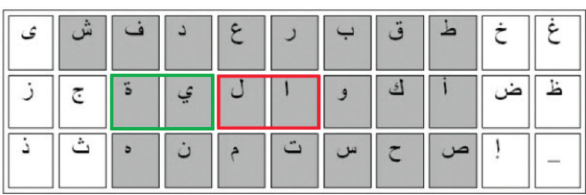
Figure 3: The optimized arrangement for the Arabic keyboard using Simulated Annealing